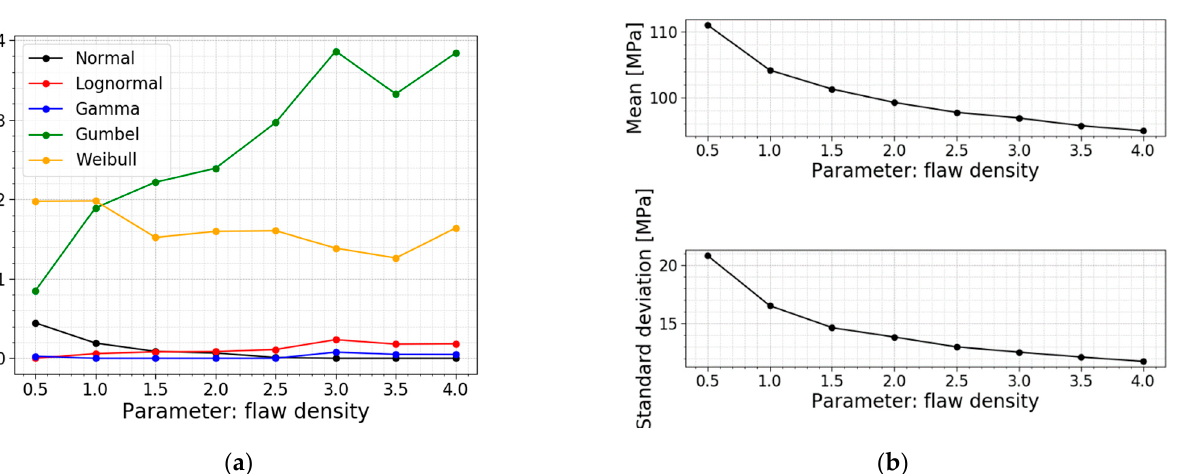
Figure 22. ( a ) AIC values and ( b ) the mean and st.dev. of the normal stress at failure for a varying flaw density.